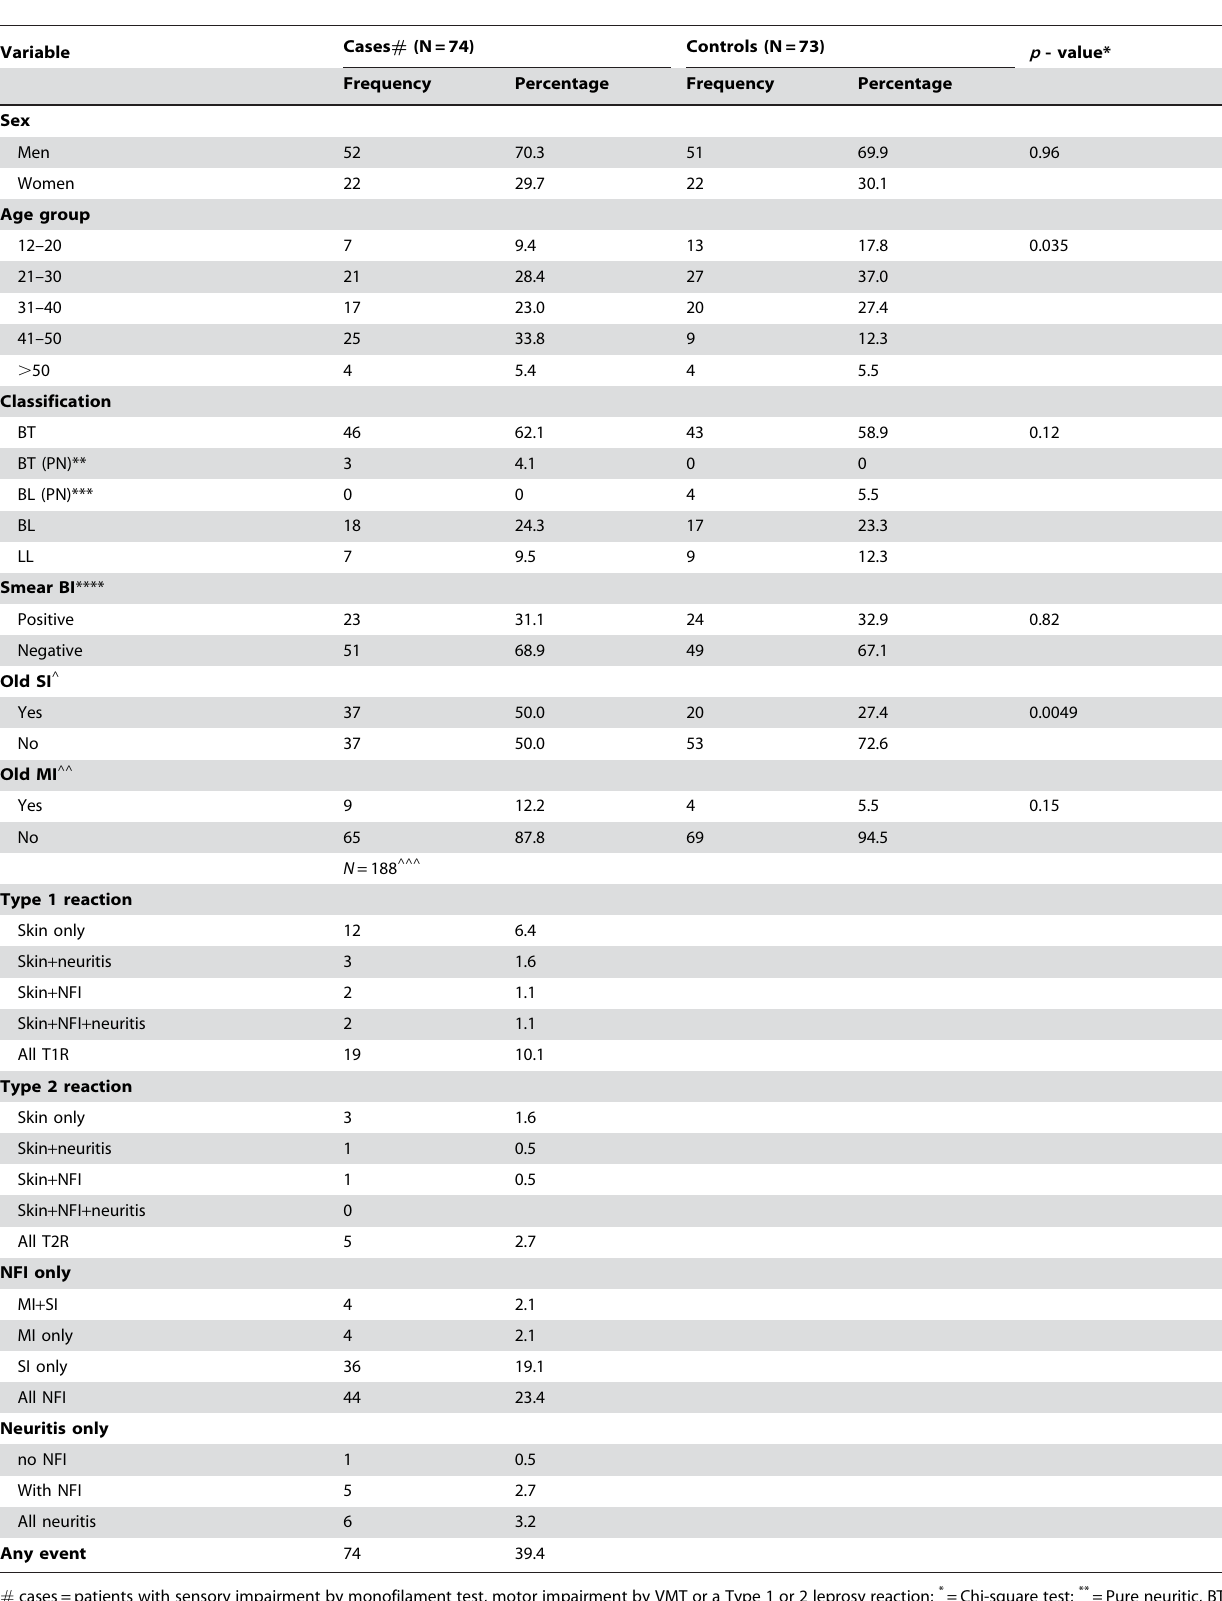
Table 1. Characteristics and outcome details of the subjects in the incidence cohort of the INFIR Cohort Study ( N = 188).